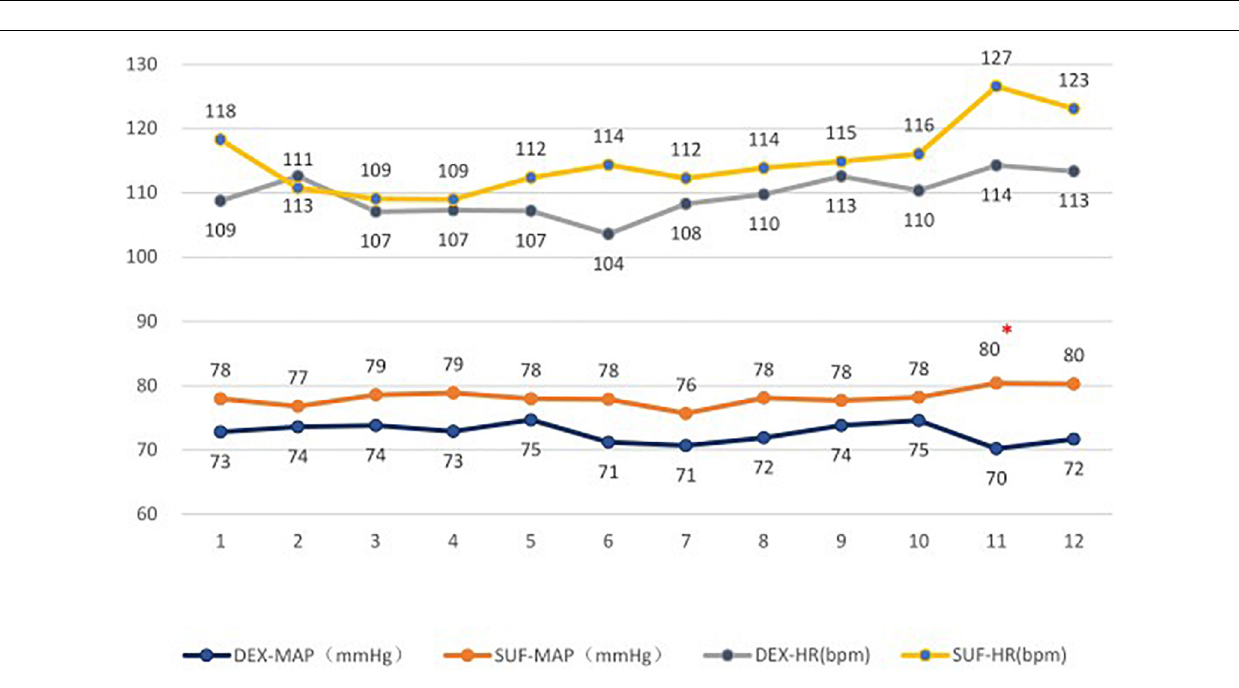
FIGURE 2 | Heart rates (HR) and mean arterial pressure (MAP) in patients aged 1–6 years old in the SUF and DEX experimental groups. ∗ P < 0.05, from the comparison between the SUF and DEX